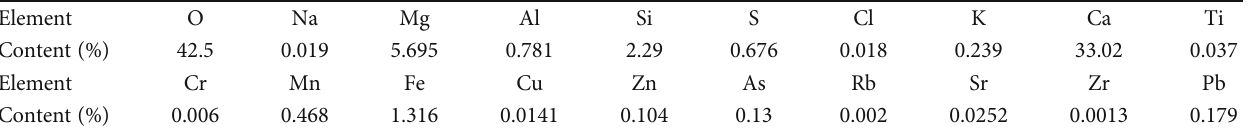
Figure 2: Size distribution curve of the tailings. Table 1: Elemental components of the